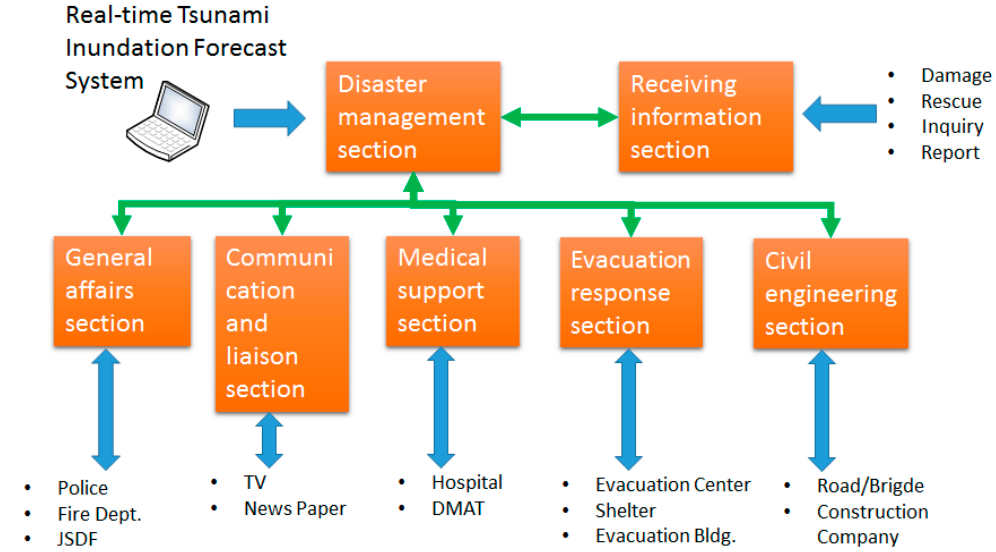
Figure 8. The organization of the disaster headquarters in the first TTX and the flow or order of information. DMAT: Disaster Medical Assistance Team, JSDF: Japan Self-Defense Forces.